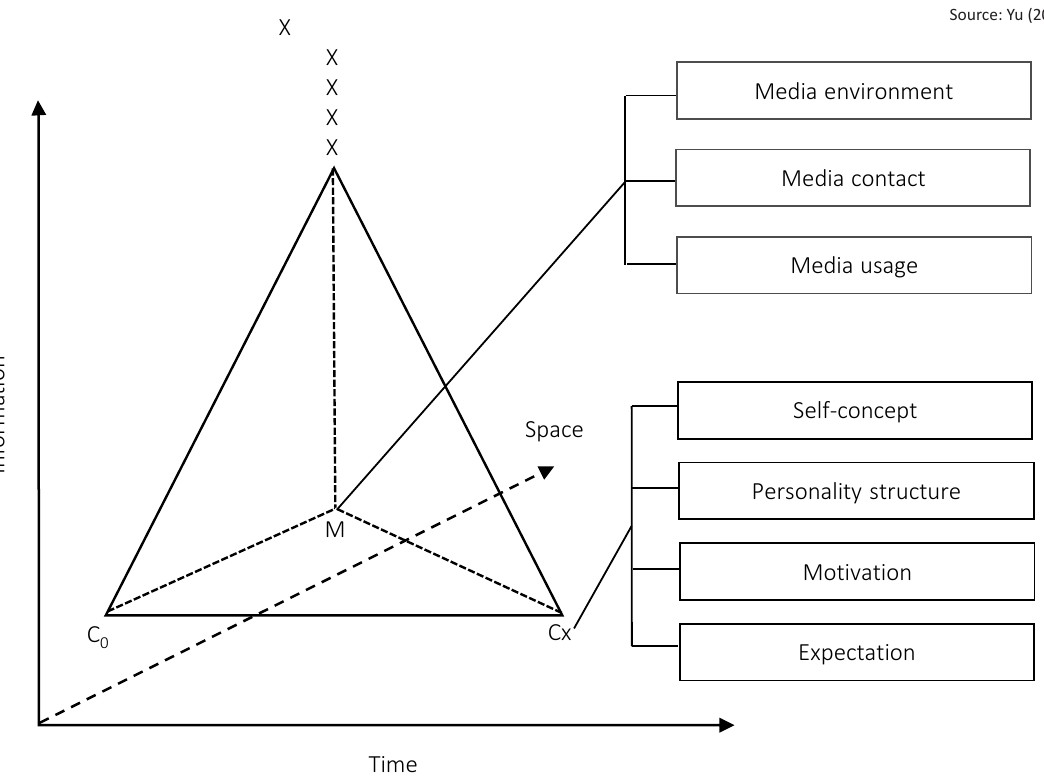
Figure 2. “Pyramid” three-dimensional transmission